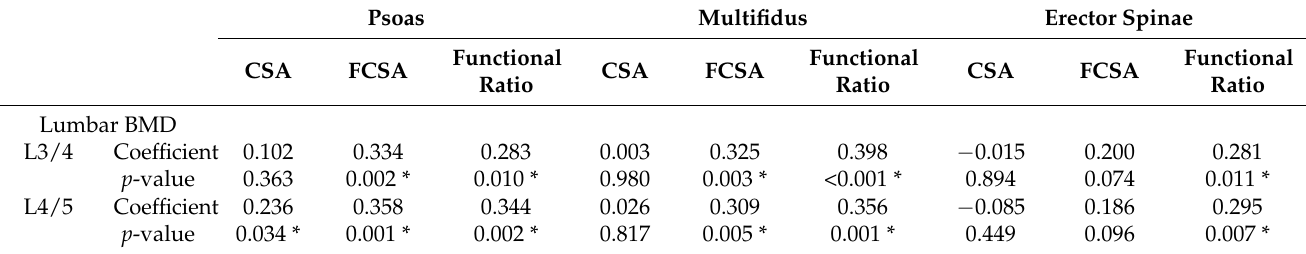
Table 4. Cont. Total femur BMD L3/4